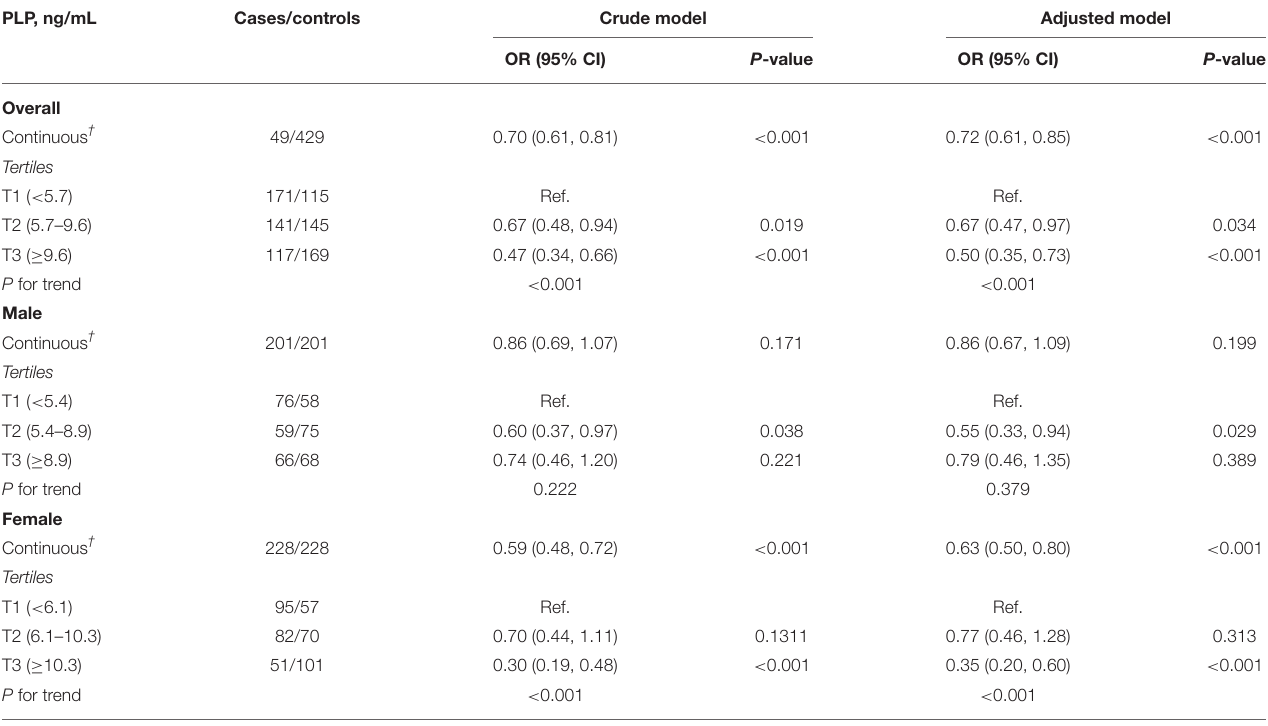
TABLE 2 | Association between plasma PLP and risk of